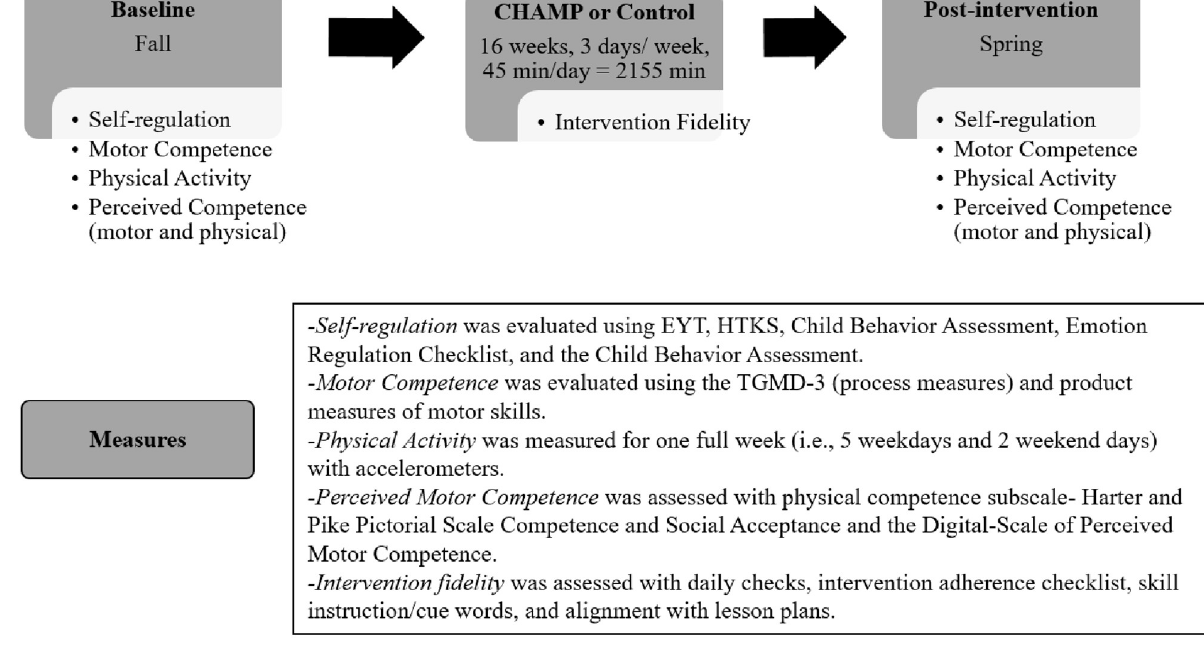
Fig 2. PATH-SR study